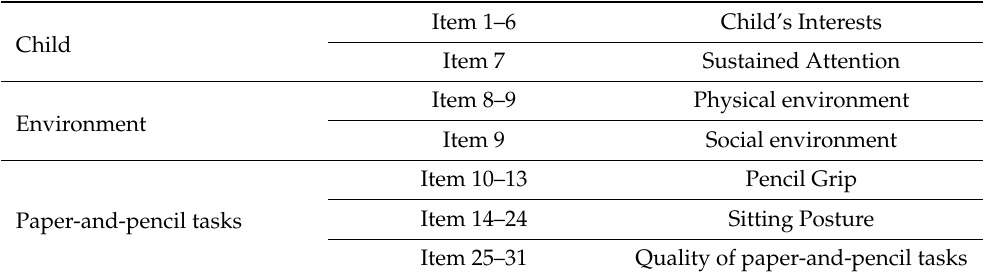
Table 2. Identification of items by area of analysis in the questionnaire for content validation.